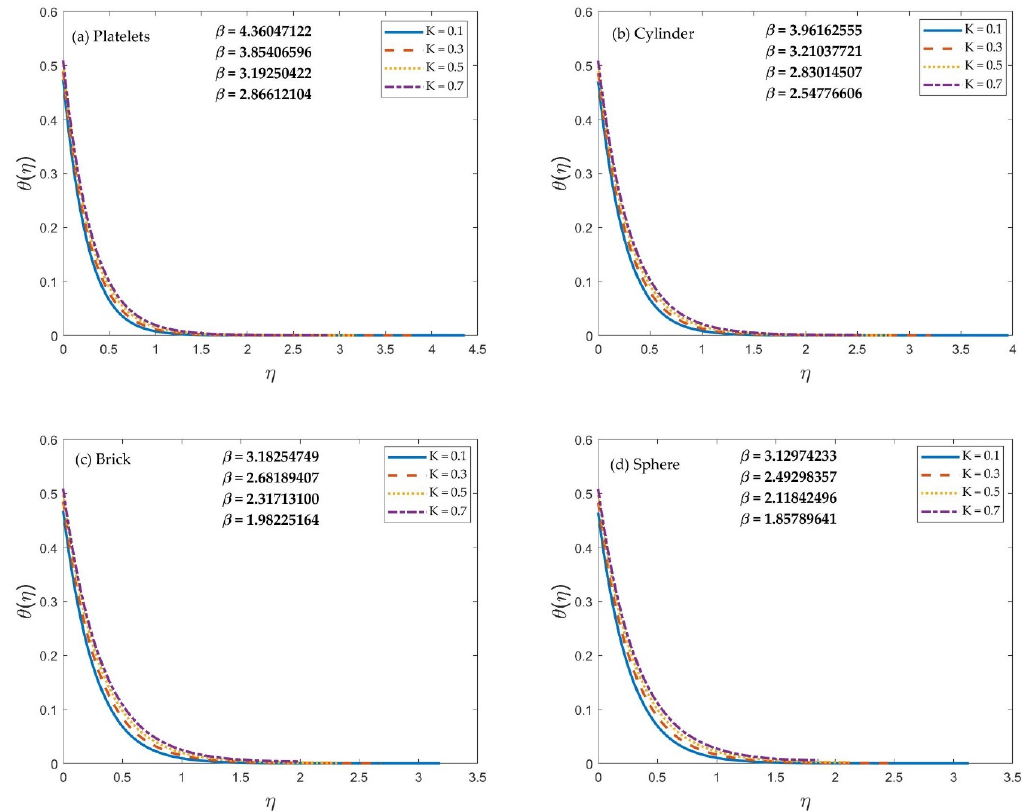
Figure 3. Impact of the slip parameter 𝐾 on the temperature profile for 𝑆 = 0.4 , 𝜑 = 0.02 , 𝑀 = 1.0 , 𝐵𝑖 = 3.0 , 𝜆 = −2.0 , 𝛼 = 𝜋 4⁄ and 𝑃𝑟 = 8.0 .